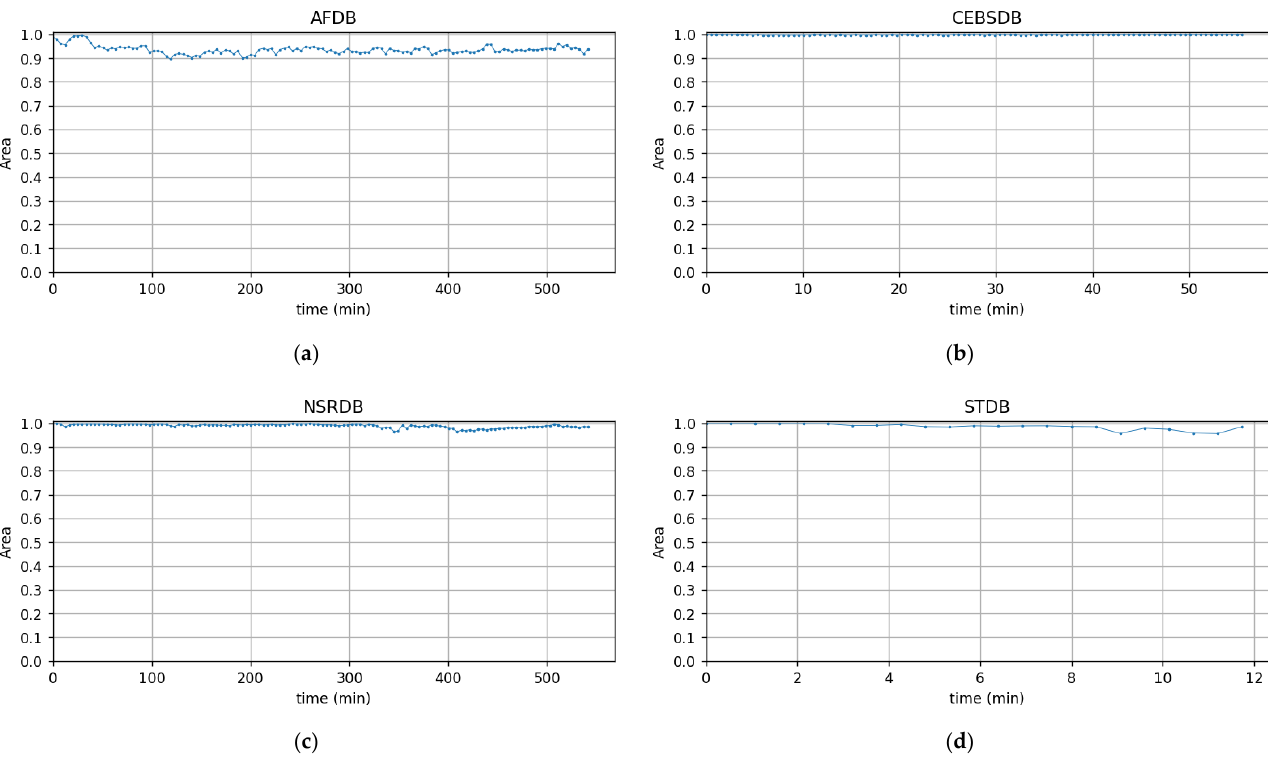
Figure A7. Area under ROC curve of individual verification is plotted against time separation for: